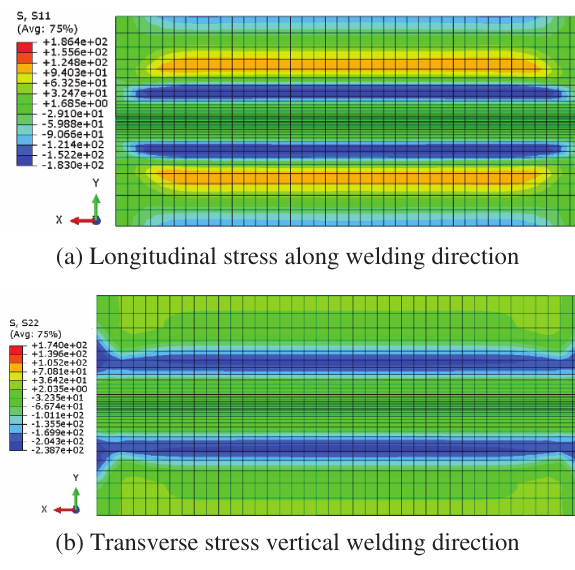
Figure 11: Welding stress distribution.